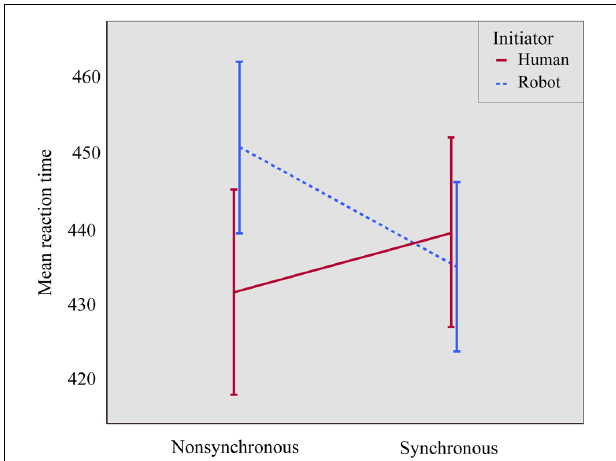
FIGURE 4 | The effect of the interaction of synchrony and initiator on RT. Error bars represent standard errors. Participants in the human initiator group were faster in the non-synchronous compared to the synchronous condition ( M synchronous = 439, SD synchronous = 11.9; M non − synchronous = 432, SD non − synchronous = 12.6), whereas participants in the robot initiator group were faster in the synchronous compared to the non-synchronous condition ( M synchronous = 435, SD synchronous = 12.2; M non − synchronous = 451, SD non − synchronous = 12.8).